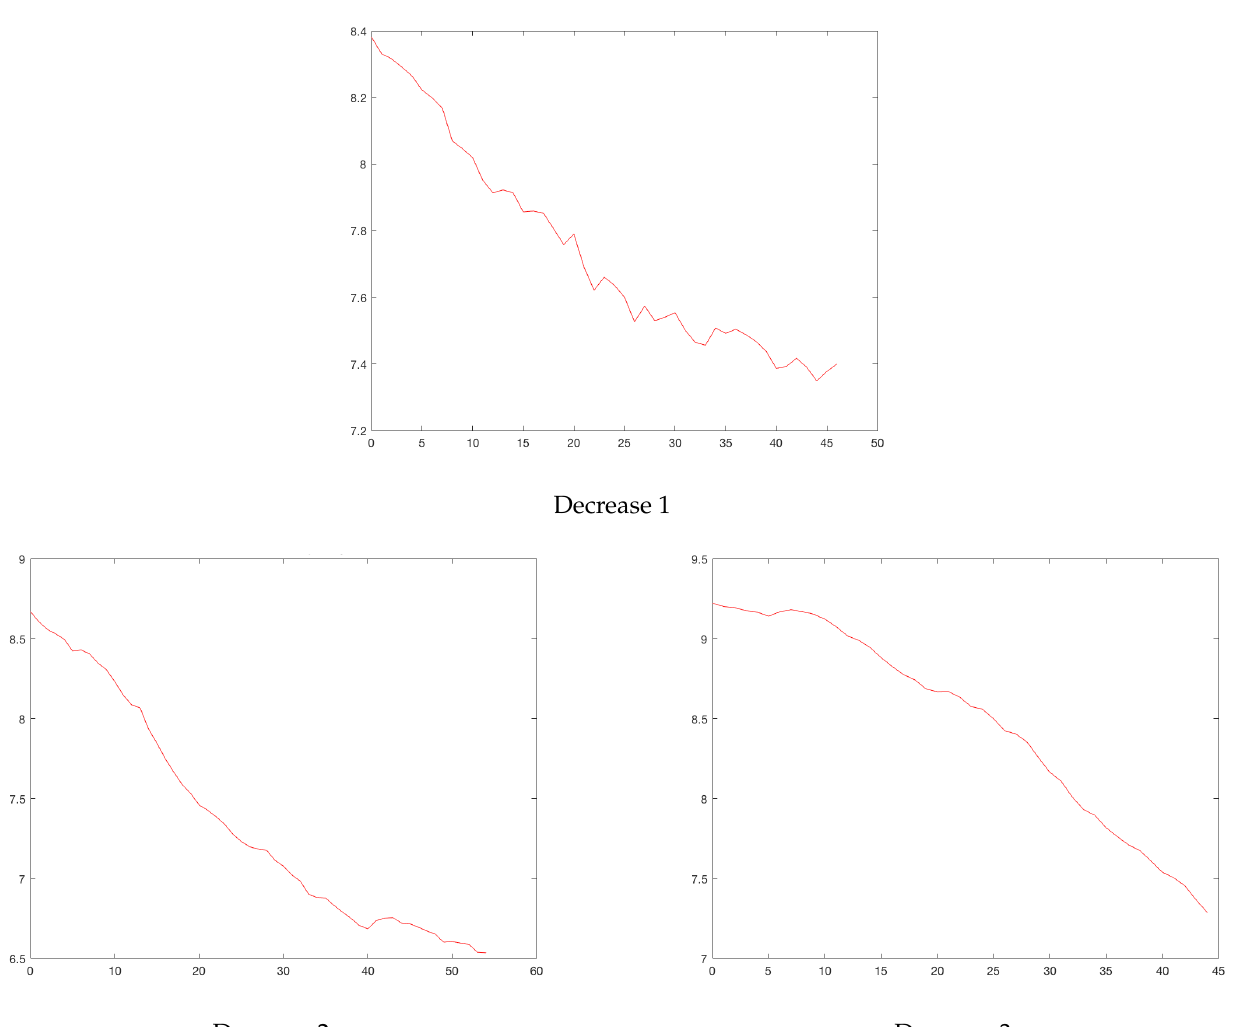
Figure 5. Bogota’s drops. Horizontal axis, days; vertical axis, logarithm of daily